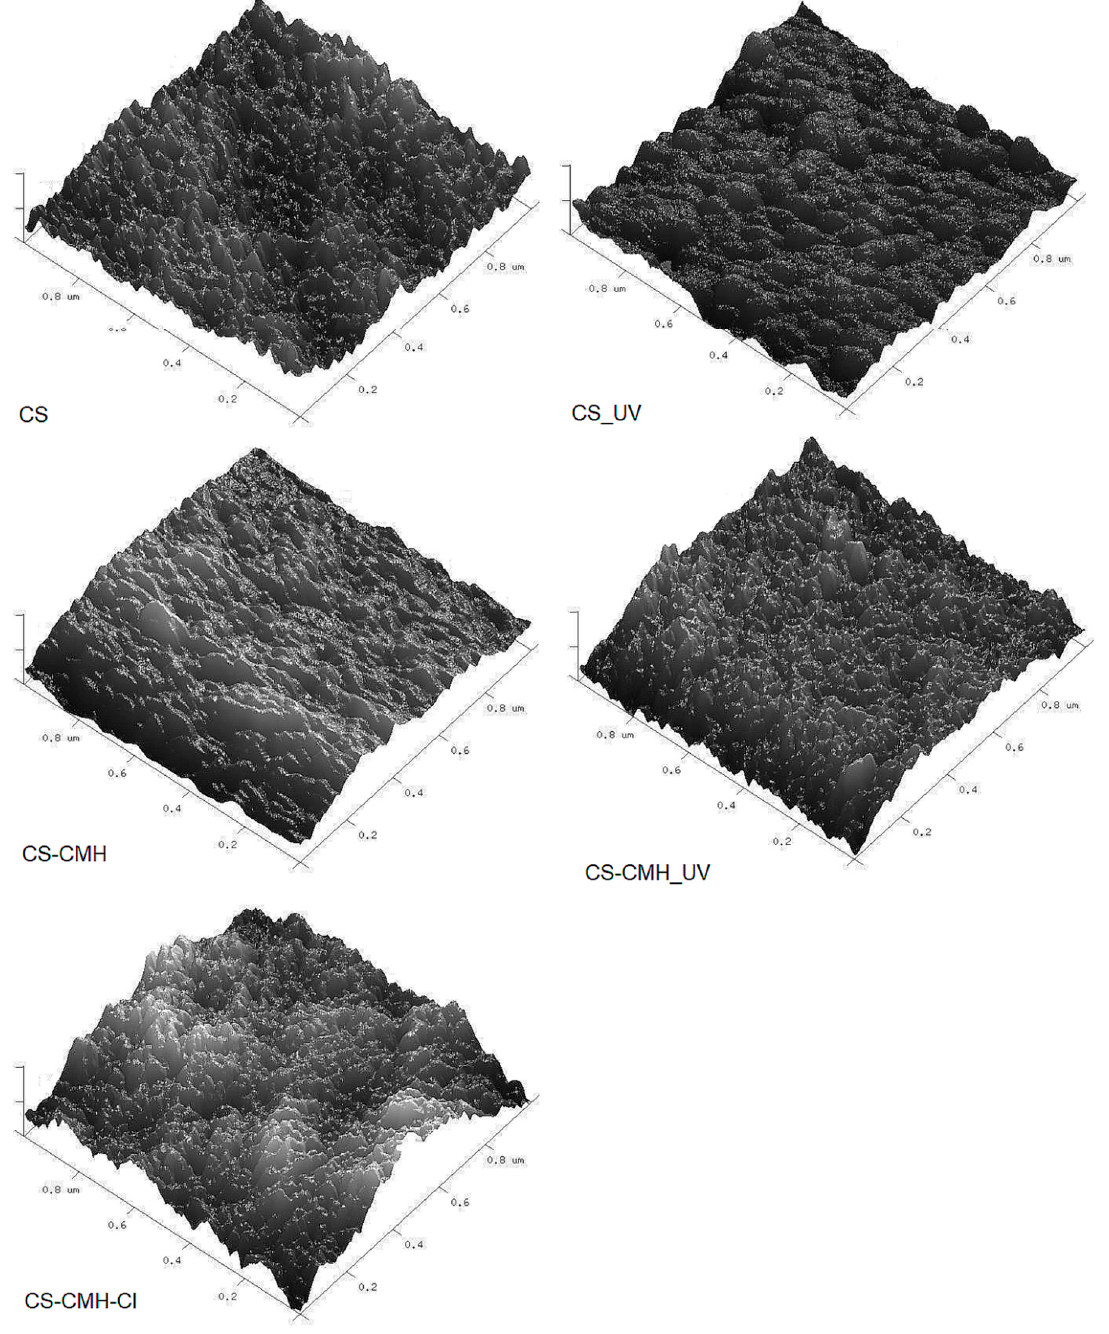
Figure 8. Atomic force microscopy (AFM) images of the received CS materials. Scan area: 1 μ m × 1 μ m and z-scale 10 nm ( left : non-irradiated samples, right : irradiated samples).